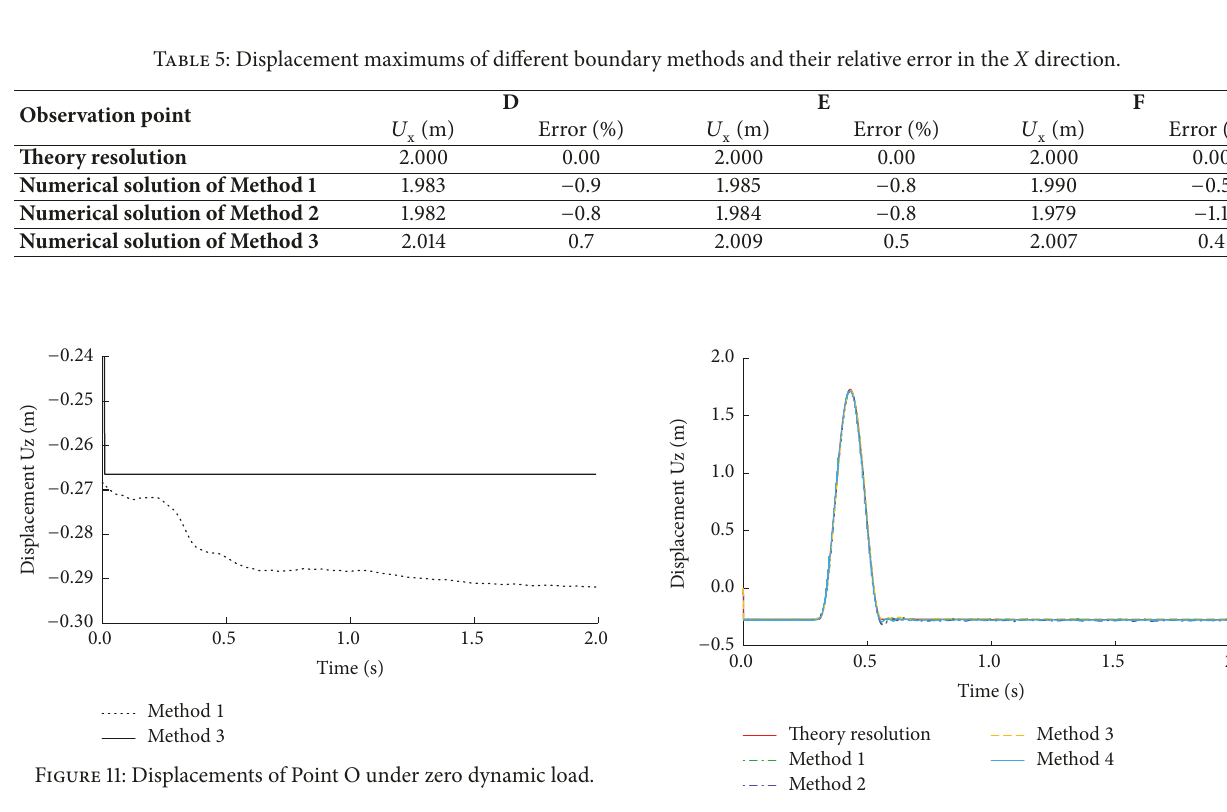
Figure 13: Z component displacement of Point